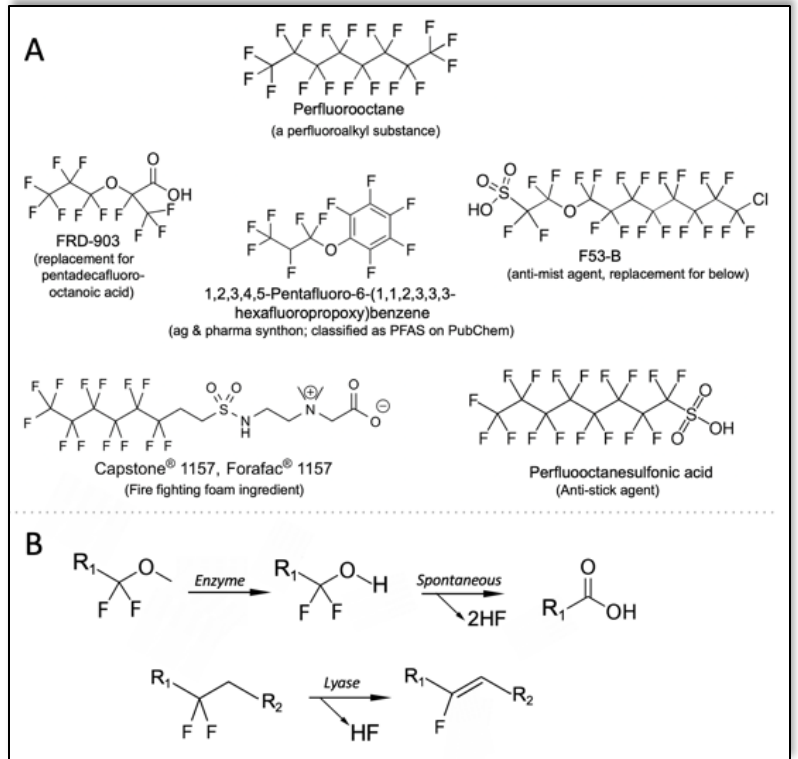
Figure 1. Polyflourinated organic compounds (PFCs) and mechanisms for their defluorination. ( A ) A perfluorinated alkane (top) and commercial PFCs showing the types of functionalities typically combined with perfluorinated moieties. ( B ) Two types of mechanisms by which a functionality adjacent to a perfluorinated carbon can be attacked enzymatically leading to facile defluorination.